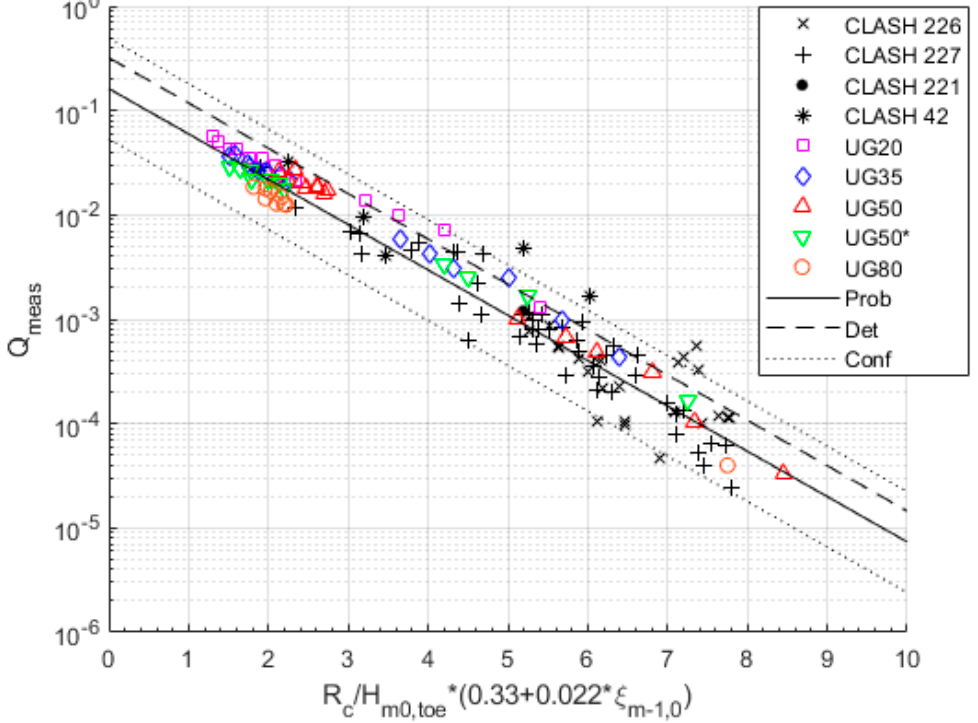
Figure 10. Wave overtopping data and prediction using the Altomare et al. [2] approach in EurOtop [3] with 5% upper and lower exceedance limits. top [3] with 5% upper and lower exceedance